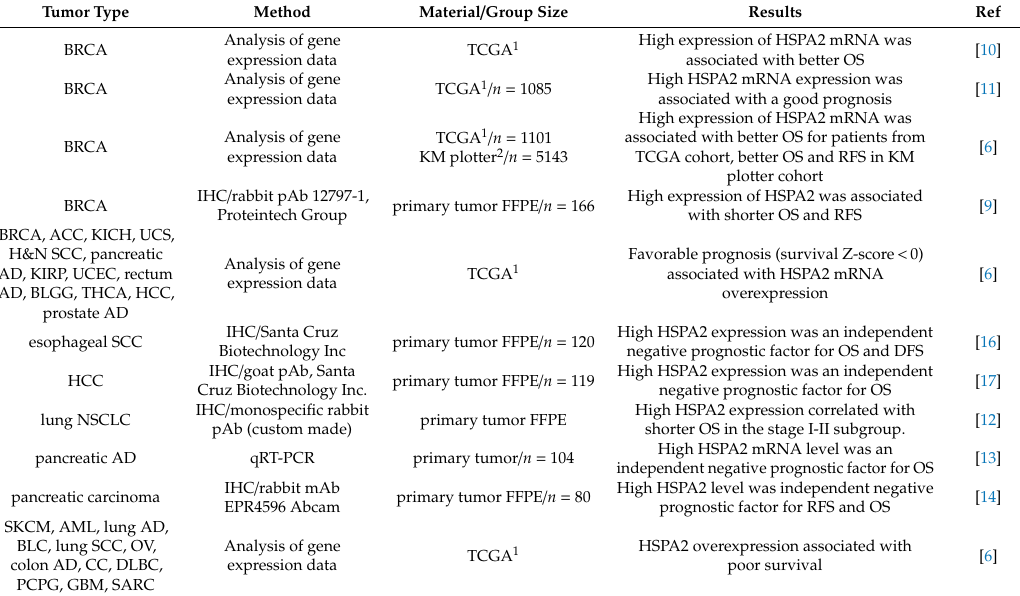
Table 1. Correlation between patient survival and HSPA2 expression at mRNA or protein level in primary